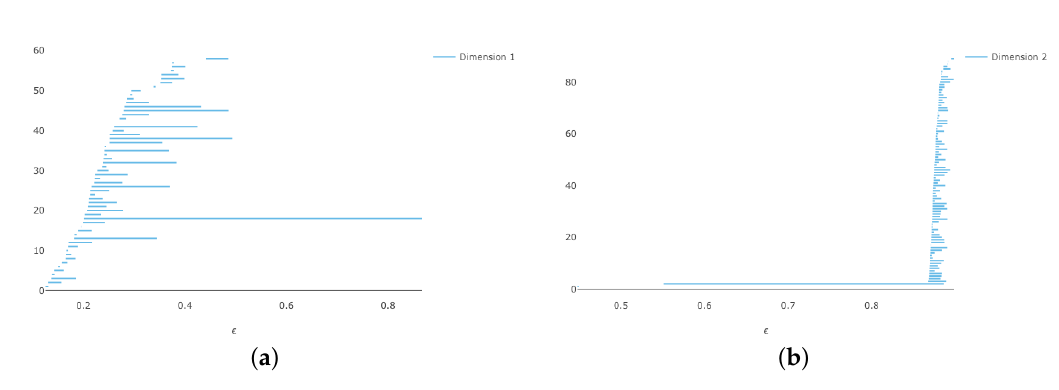
Figure 5. Vietoris–Rips persistence diagrams for 100 points on R P 2 , using the isometric embedding into R 5 ( a ) H 1 persistence and ( b ) H 2 persistence.